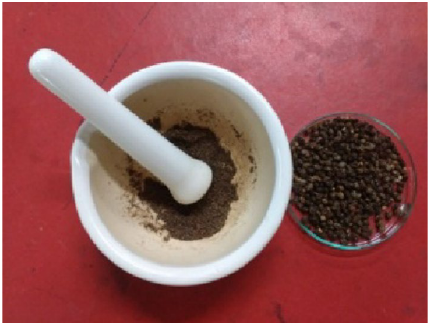
Fig. 1 Seeds powder used for